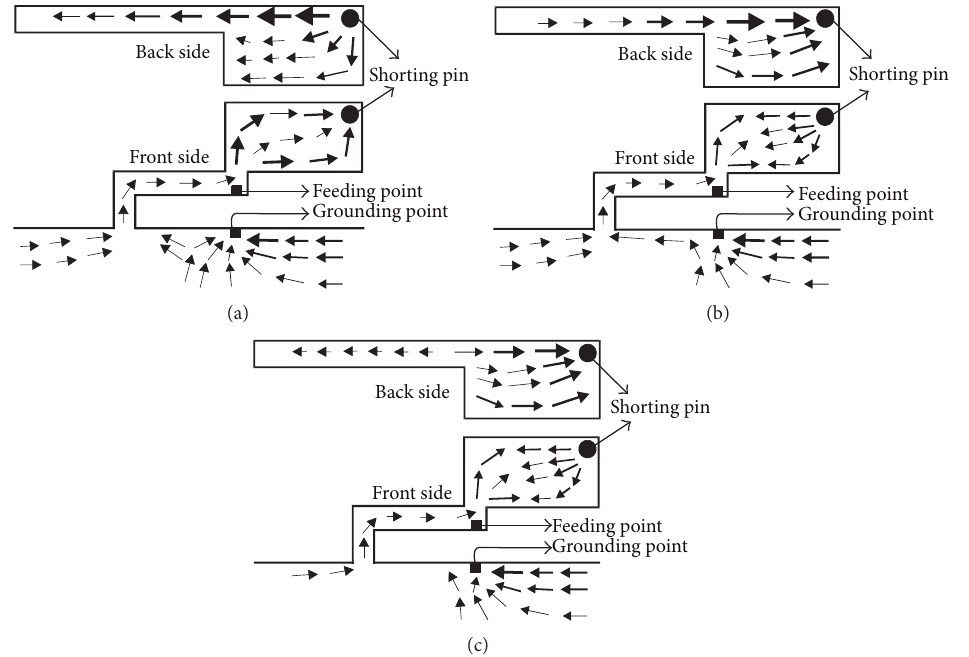
Figure 5: Simulated surface current distributions obtained at (a) 2.45, (b) 5.2, and (c) 5.8 GHz for proposed FC-PIFA.